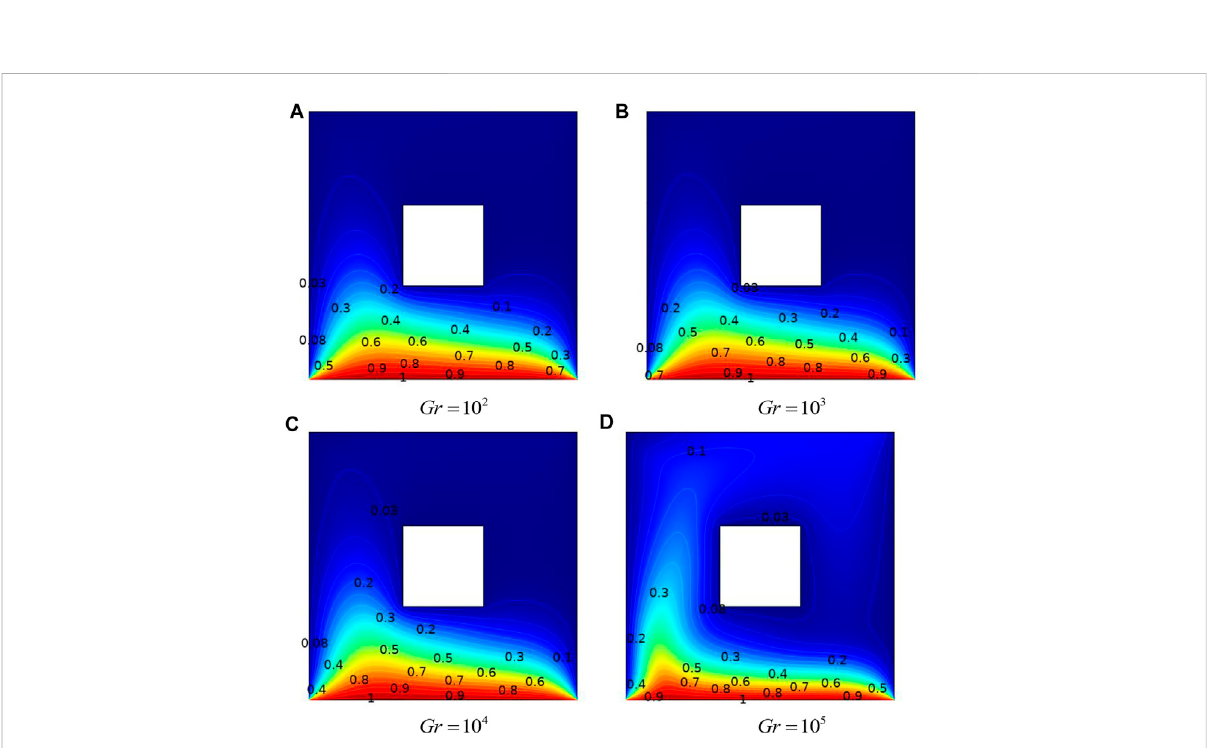
FIGURE 4 In fl uence of Gr on isotherms with a uniformly heated bottom wall: cold cylinder case, Ha (cid:2) 20 and Re (cid:2)